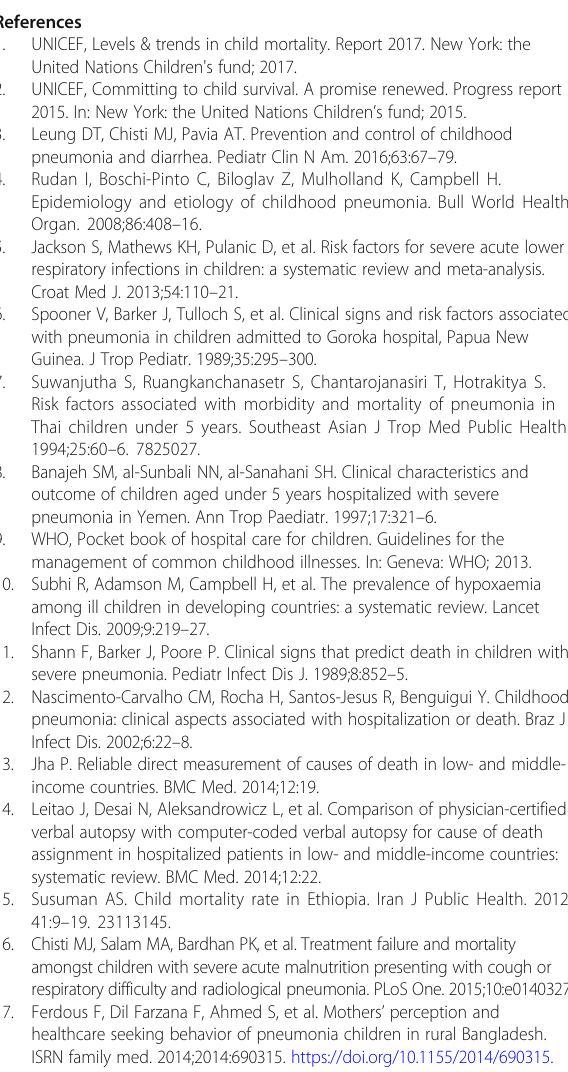
Additional file 1: Table S1. Correlation between pneumonia and co-variates. (DOC 42 kb) Additional file 2: Table S2. Correlates of pneumonia deaths compared to other causes of deaths in children aged 4 weeks to 59 months in rural Bangladesh. (DOC 56